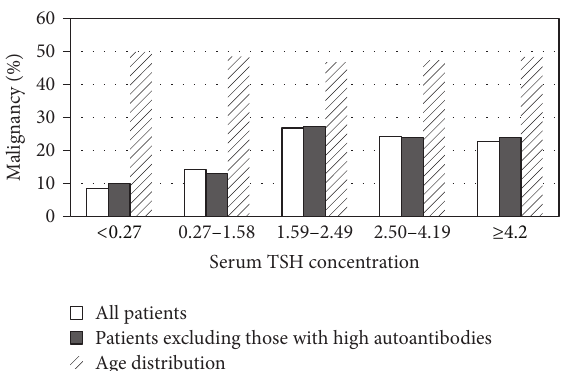
Figure 3: The distribution of patients based on TSH range and historical diagnosis.